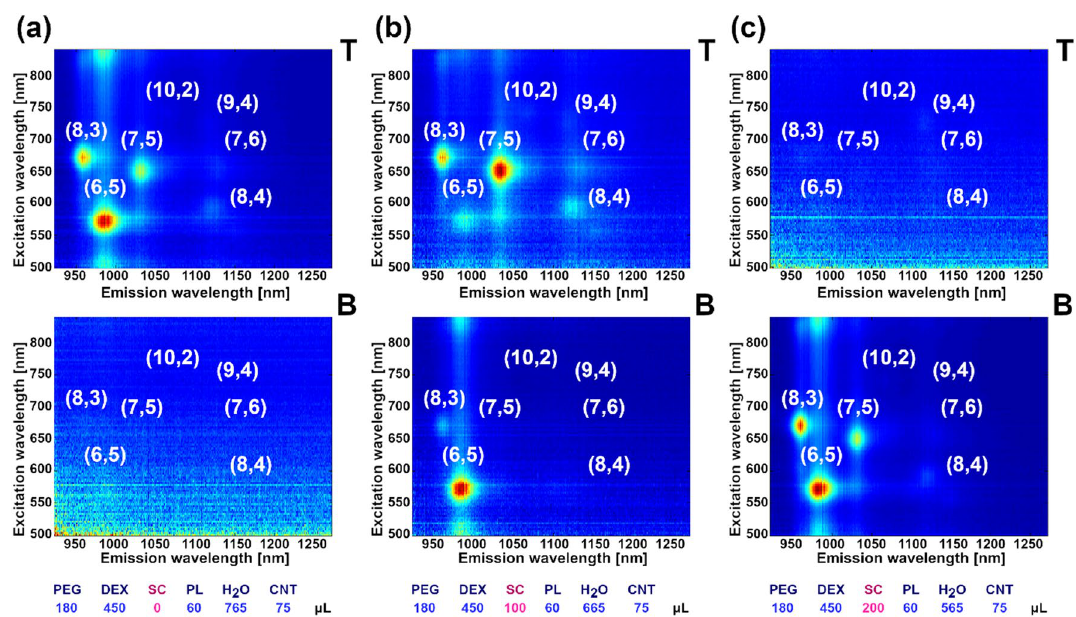
Figure 2. 2D PLE maps of SC-dispersed, (6,5)-enriched SWCNTs sorted by ATPE upon varying the added volume of SC. Example volumes: ( a ) 0 µL, ( b ) 100 µL and ( c ) 200 µL of SC. 2D PLE maps of remaining samples are shown in Supplementary Animation 1. Analogous data for unsorted SWCNT material is presented in Fig. S2 and Supplementary Animation